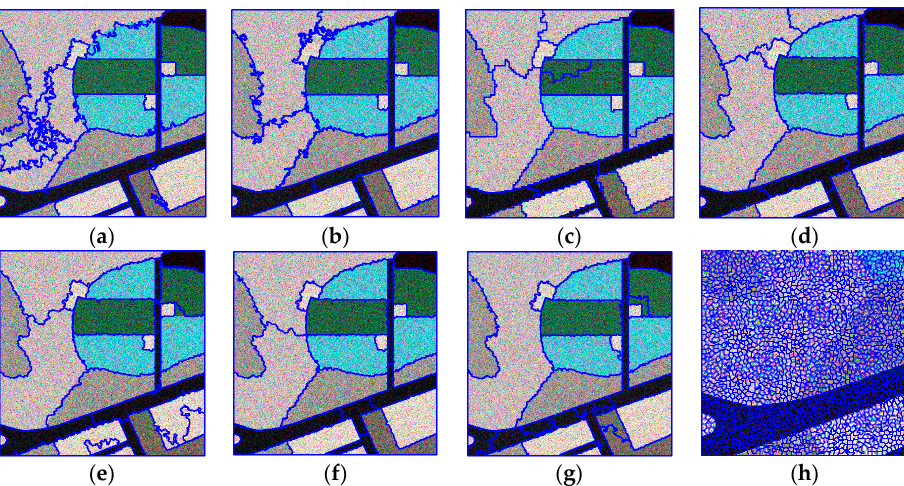
Figure 6. Segmentation results of the simulated image using different methods: ( a ) FNEA segmentation based on Freeman decomposition without SAR statistical features (FFD), ( b ) FNEA segmentation with Pauli RGB image without SAR statistical features (FPD), ( c ) improved FNEA with G 0 statistical features start from square blocks (IFGB), ( d ) improved FNEA using Wishart statistical features with pre-segmenting by simple linear iterative clustering (SLIC) (IFWS), ( e ) improved FNEA using K statistical features with pre-segmenting by SLIC (IFKS), ( f ) improved FNEA using the G 0 statistical features with pre-segmenting by SLIC (IFGS), ( g ) segmentation using the G 0 statistical features without shape features based on SLIC pre-segmenting (IFGS-S), and ( h ) SLIC (local enlarged drawing of lower-left part of the superpixel map). Table 1. Segmentation accuracy measures of the simulated image.